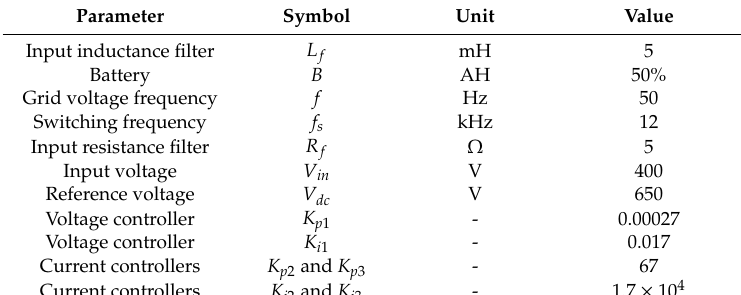
Table 3. Parameter specifications for Level 3 charging.